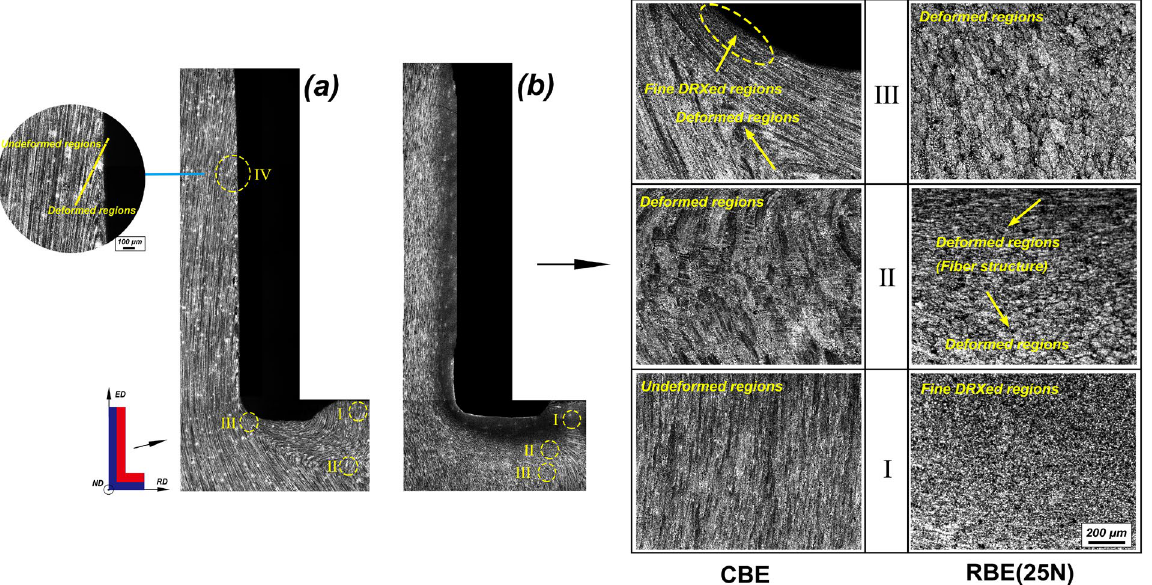
Figure 6. Macroscopic OM images of ( a ) CBE and ( b ) RBE (25 N) samples marked with highly magnified regions containing corresponding deformation characteristics (I, II, III and IV: the typical deformation region of CBE or RBE samples).